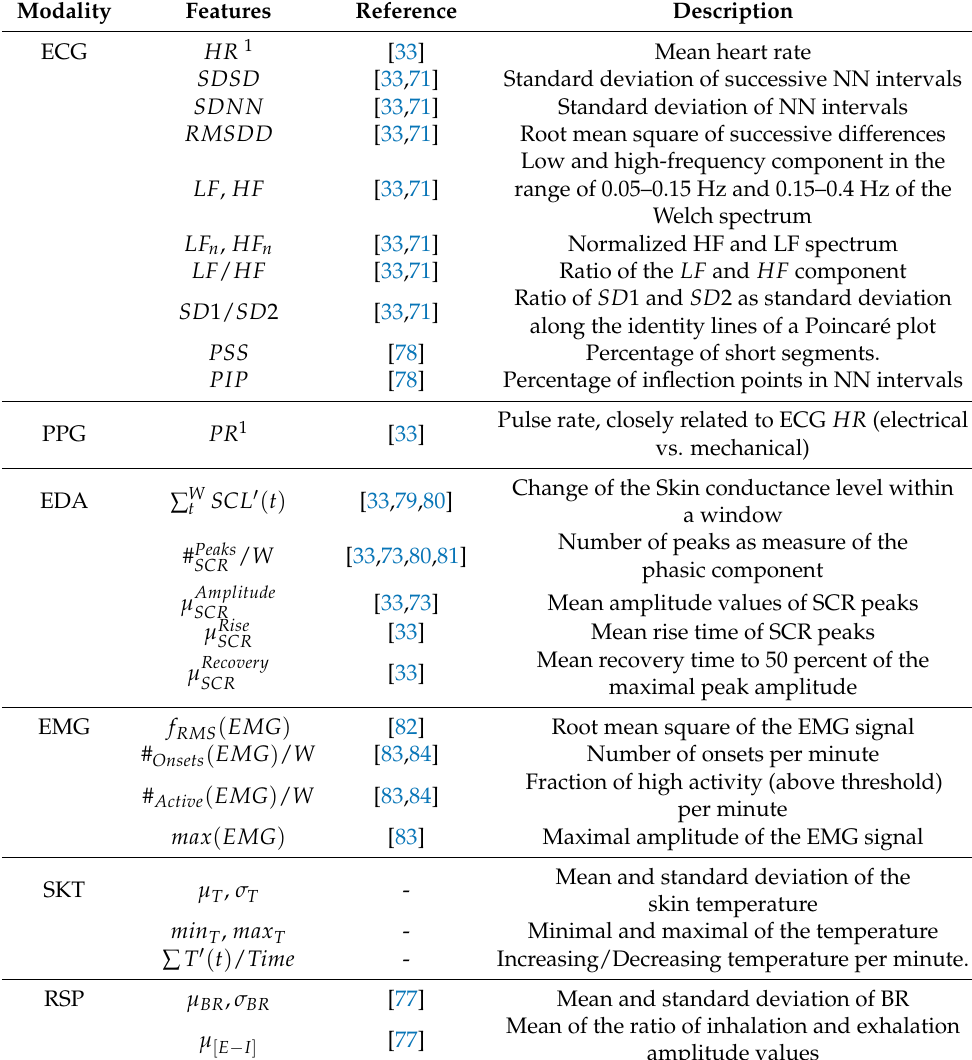
Table 1. List of extracted expert and statistical features from the recorded biosignal